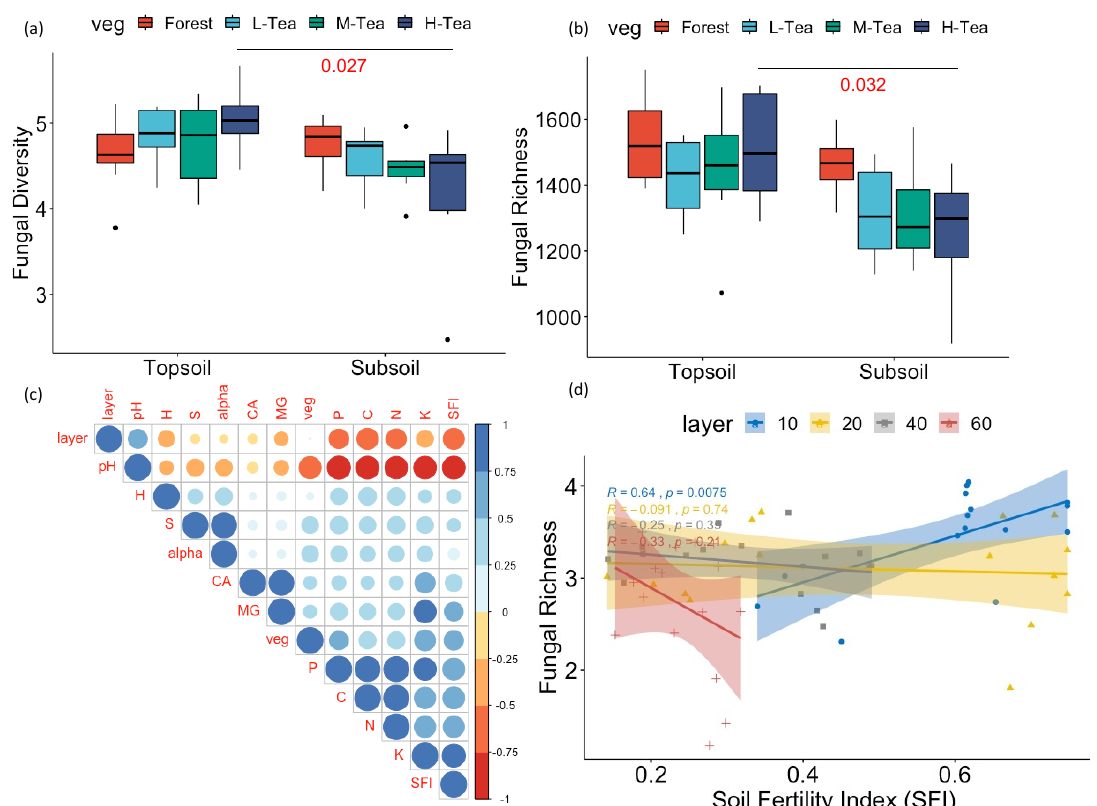
Figure 1. Fungal diversity ( a ) and richness ( b ) in topsoil and subsoil in forests compare to tea plantations under high, low, and moderate fertilizer inputs. ( c ) the correlation between fungal diversity indexes with environmental factors. Layer: soil layers, H: fungal Shannon diversity, S: species richness, apha: apha diversity, veg: vegetation types, CA: soil total Ca, MG: soil total Mg, P, N, C: soil total P, N, C, SFI: soil fertility index; ( d ) correlation between SFI and soil fungal diversity (Shannon index).